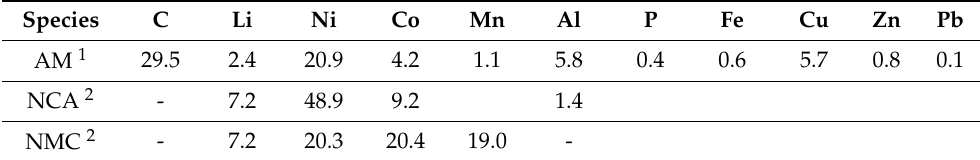
Table 1. Chemical composition of used materials. (mass fraction, w/%). Species